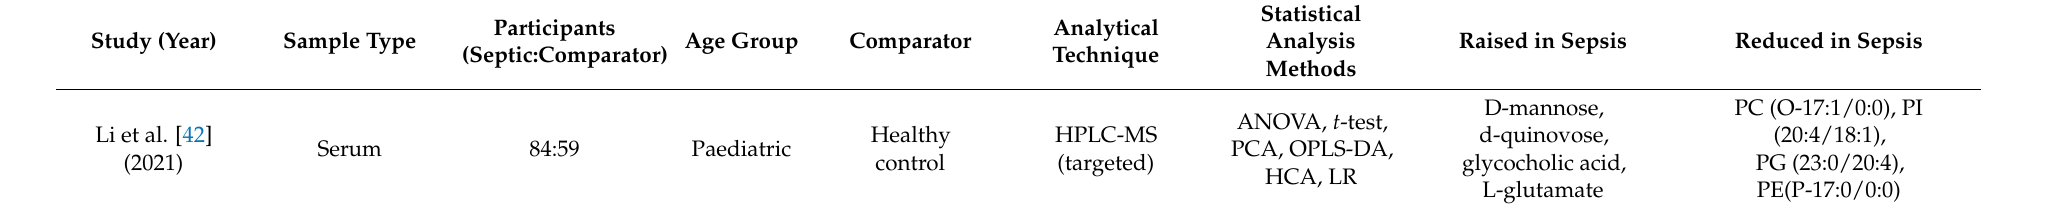
Table 1. Metabolomic studies focusing on the diagnosis of